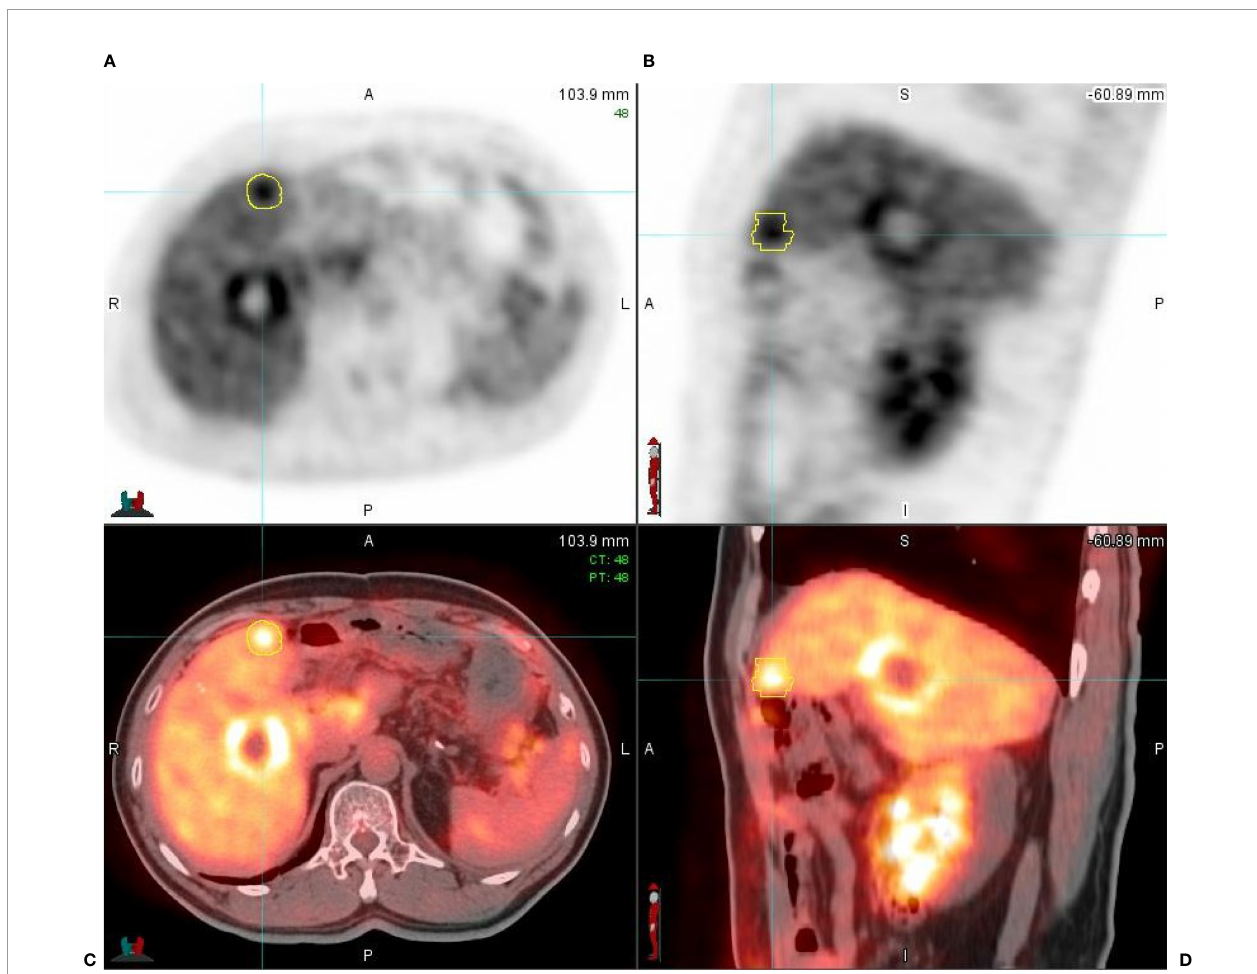
FIGURE 3 | A 65-year-old male patient with hepatic metastasis from a primary rectal cancer. (A) Axial respiratory gated PET image (PET_0% sorted) shows two liver lesions with an increased uptake of FDG; one of the liver lesions is contoured (in yellow), measuring 2.5 cm × 2.3 cm in diameter with SUV max = 9.24, conforming to liver metastasis. (B) Sagittal respiratory gated PET image (PET_0% sorted); one of the lesions is contoured (in yellow), measuring 2.8 cm in diameter with SUV max = 9.24. (C, D) The respiratory gated PET axial and sagittal images fused with respiratory gated CT images (PET/CT_0% sorted); the high FDG uptake area is presented in thermal color and CT images are in gray